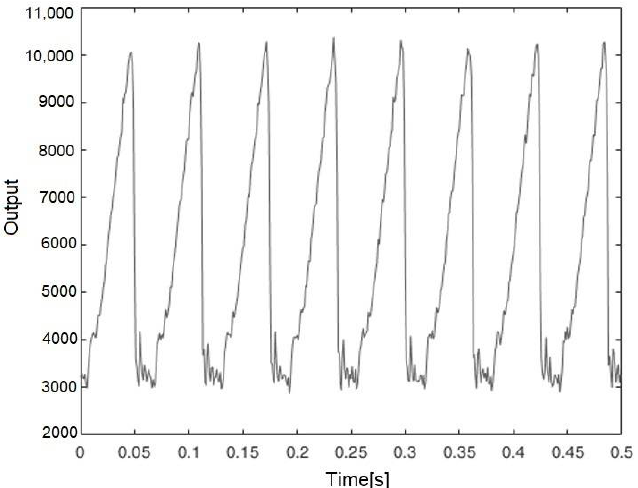
Figure 12. The output of the proposed sensor vs. time for the spinning gray gradient target placed 1 m from the sensor.